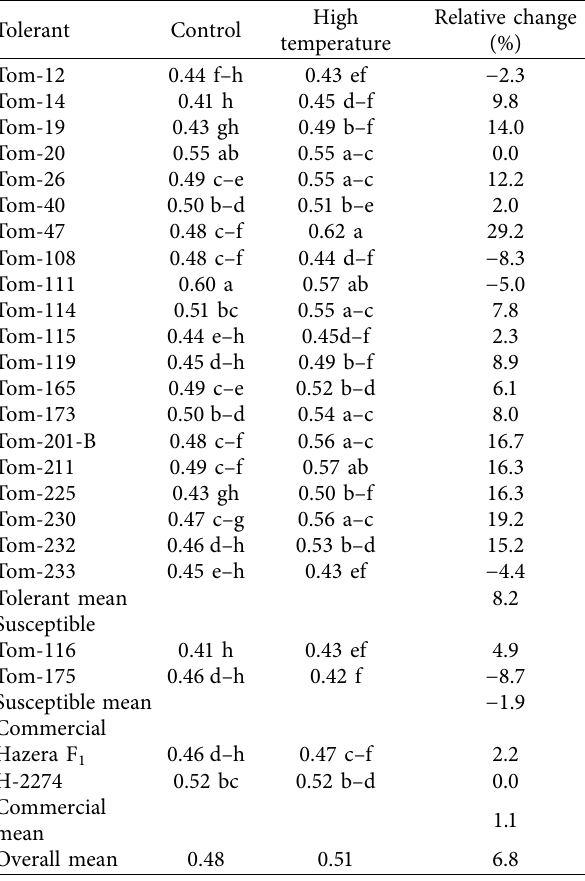
Different letters in each column indicate significance ( P < 0 . 05), FW: fresh